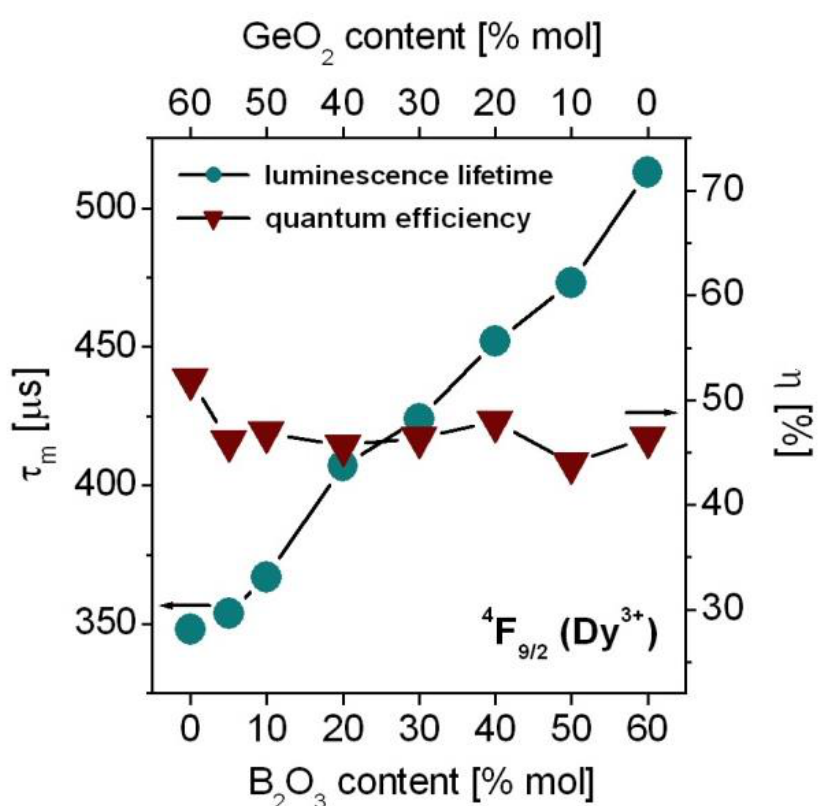
Figure 9. Luminescence lifetimes and quantum efficiencies for the 4 F 9/2 state of Dy 3+ ions in borogermanate glasses.